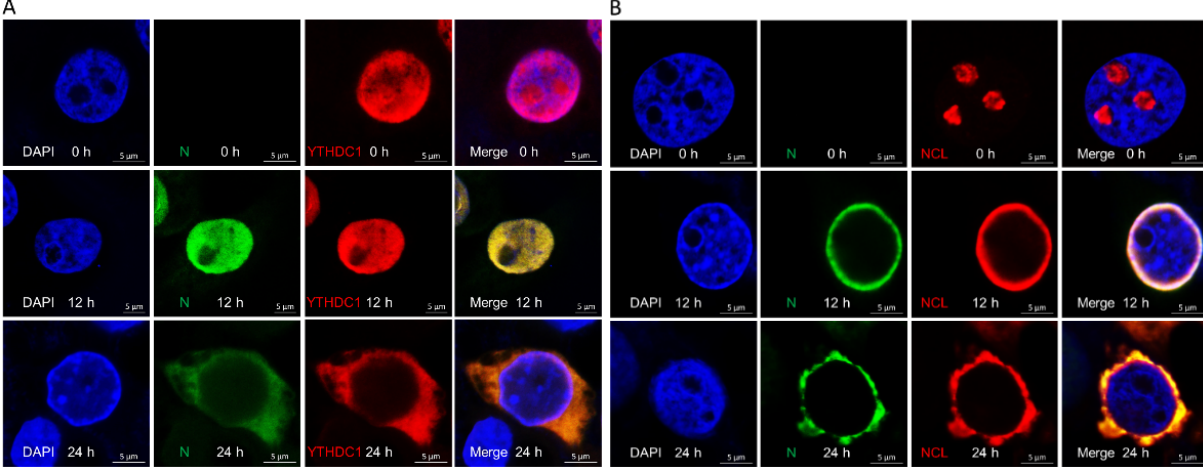
Figure 6. YTHDC1 and NCL relocate from the nucleus/nucleolus to the cytoplasm induced by PEDV infection. ( A , B ) Immunofluorescence analyses of YTHDC1 and NCL protein localization during PEDV infection. IPEC-DQ cells were infected with PEDV at a MOI of 0.5. The cells were fixed at 12 and 24 hpi and incubated with the antibodies corresponding to PEDV N, YTHDC1, and NCL followed by the FITC-conjugated goat anti-mouse IgG (green) and Alexa Fluor-546 conjugated donkey anti-rabbit IgG (red) secondary antibodies. Nuclei were stained with DAPI (blue) and then observed under a confocal microscope. Scale bar, 10 μ m.